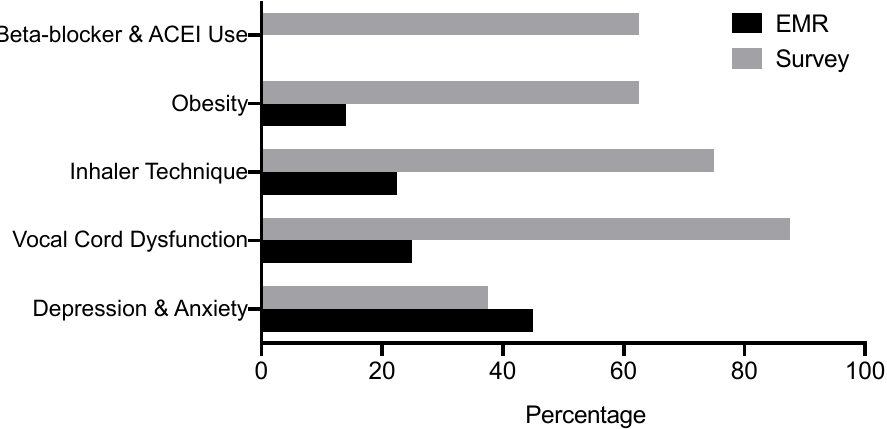
Figure 2. Asthma Comorbidities. The frequency of comorbidities addressed in a clinic based on a review of EMR data compared to the percentage of providers who reported addressing these comorbidities very frequently or always. The survey results showed a discrepancy between the EMR data and providers’ perception of their performance.